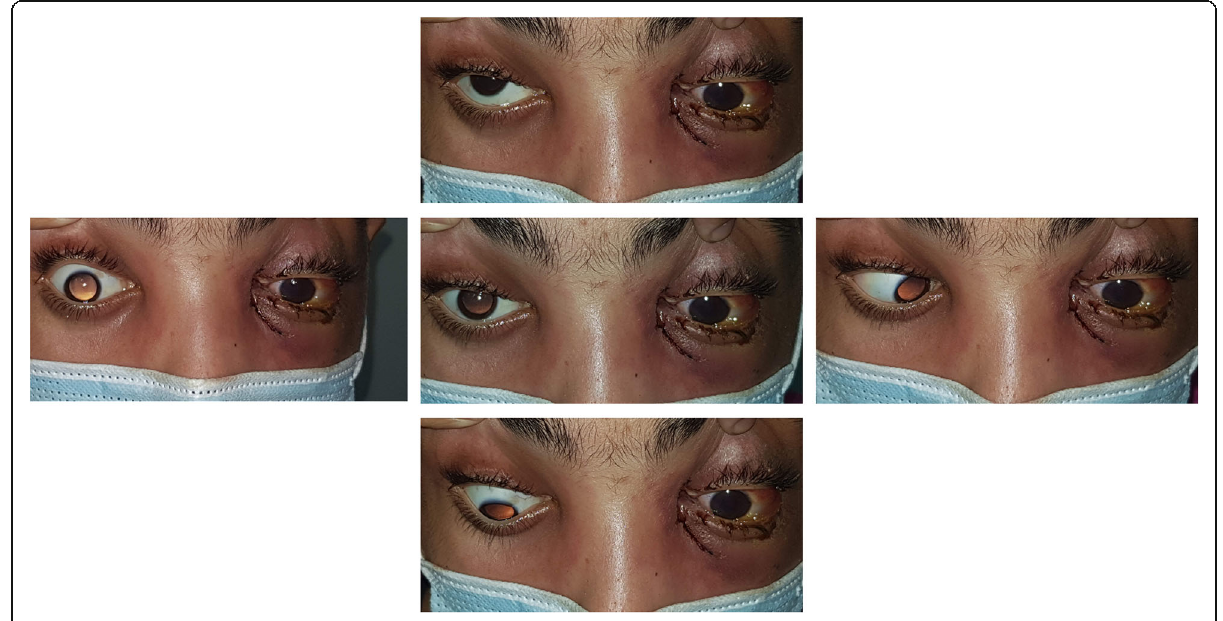
Fig. 2 Clinical photographies showing complete left ophthalmoplegia and limited right eye abduction